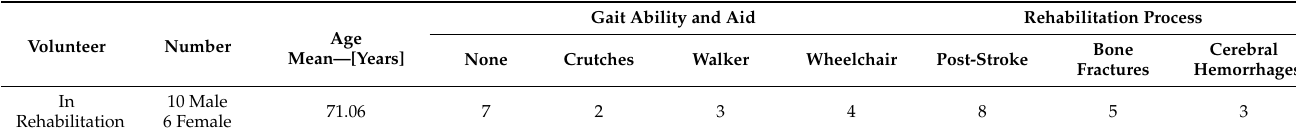
Table 2. Data of the volunteers from the hospital continuing care